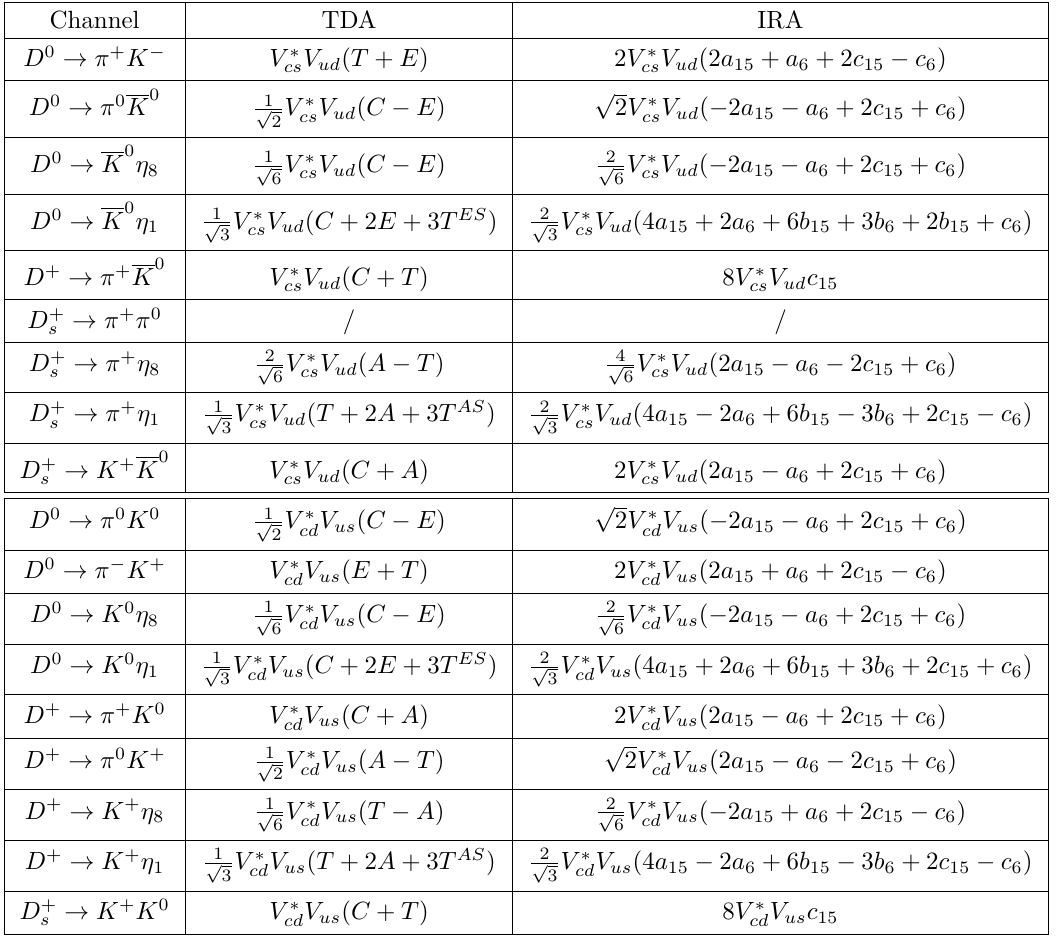
Table 1 . Decay amplitudes of the Cabibblo-allowed and doubly Cabibbo-suppressed D → PP